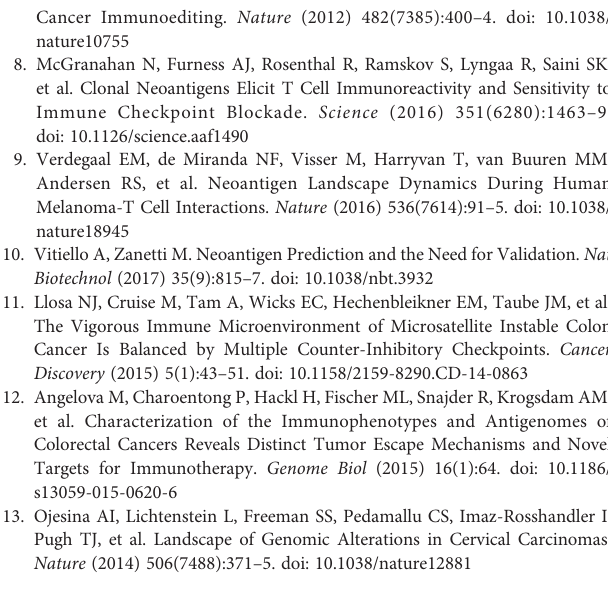
Supplementary Figure 1 | The result of H&E saining in 10 CC patients. Supplementary Figure 2 | Detail information about sample data quality control (QC) of 35 cervical neoplasia genomes. Supplementary Figure 3 | A heatmap showed the distribution of gene in CINs group. More detail information can be obtained in Supplementary Table S4 . Supplementary Figure 4 | Copy number pro fi les, ampli fi cation and deletion. GISTIC2.0 analyses of CNAs in 35 samples revealed signi fi cantly ampli fi cation and deletion regions peaks on several chromosomes. Red and blue lines represented copy number ampli fi cation and deletion events, respectively. Supplementary Figure 5 | The expression of the neoantigen-related genes and the and prognosis informatics from GEPIA database. (A – F) The expression of the neoantigen-related genes. Red indicated tumor and grey indicated normal. (G, H) Kaplan – Meier analysis comparing the groups with a different expression of IGF2R and C3orf70 in